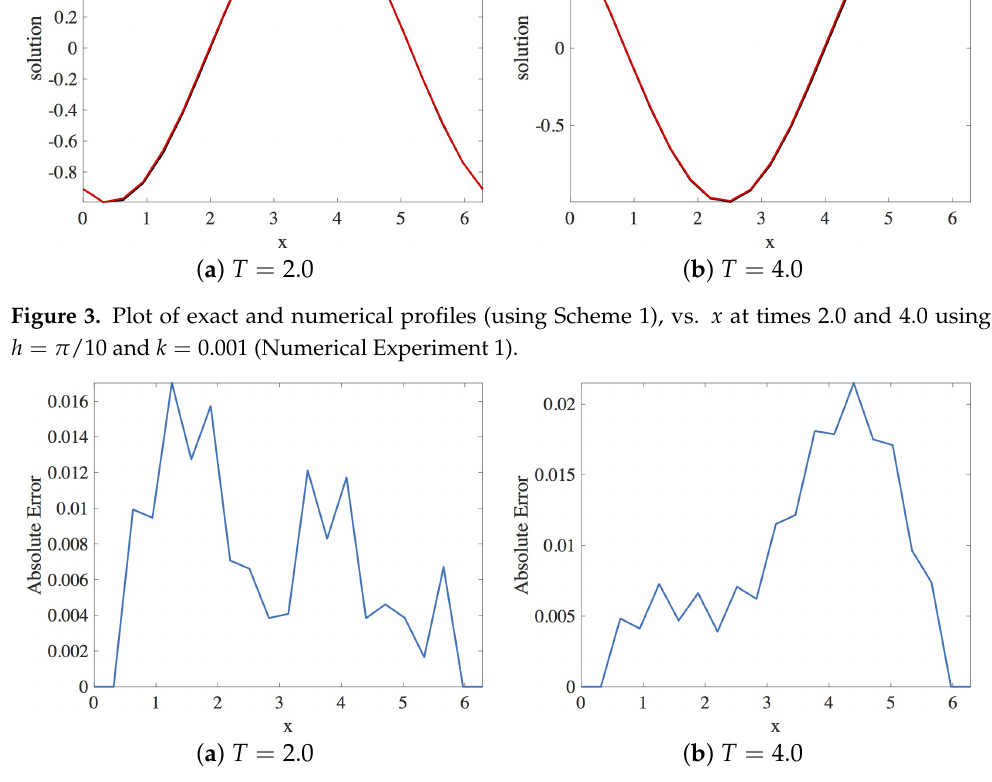
Figure 4. Plot of the absolute error vs. x using Scheme 1 for Numerical Experiment 1. The spatial and temporal step sizes are h = π /10 and k = 0.001,